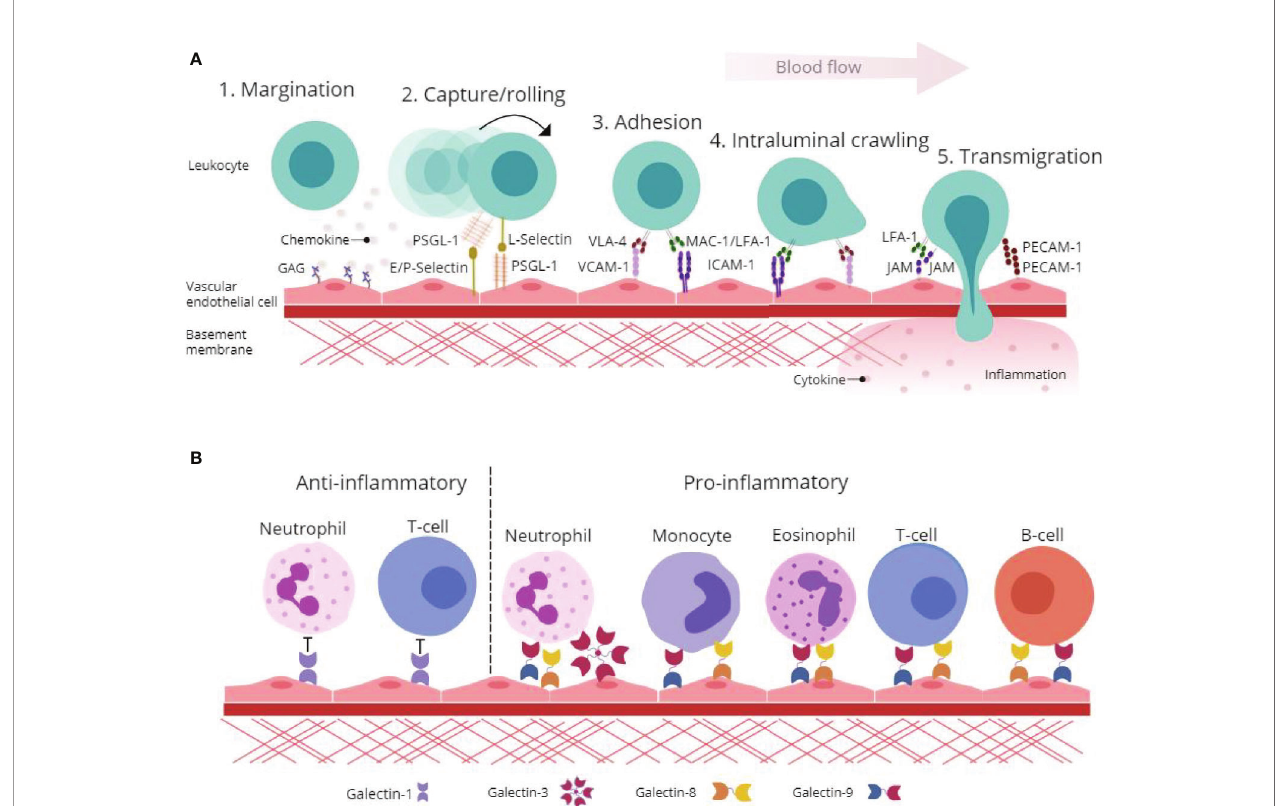
FIGURE 1 | Glycan-binding proteins regulate endothelial-leukocyte interactions in in fl ammation. (A) Protein-protein and protein-glycan interactions are crucial regulators of leukocyte-endothelial interactions involved in the leukocyte adhesion cascade. Firstly, glycosaminoglycan (GAG)-presented chemokines promote leukocyte margination to the vessel wall. Capture and rolling of leukocytes along the endothelium is facilitated by interactions between selectins and their ligands such as P-selectin glycoprotein ligand (PSGL)-1. This interaction leads to cell activation and conformational changes in leukocyte integrins including Very Late Antigen (VLA)-4, Macrophage (Mac)-1 antigen and lymphocyte function-associated antigen (LFA)-1 that then interact with adhesion molecules such as Vascular Cell Adhesion Molecule (VCAM)-1 and Intracellular Cell Adhesion Molecule (ICAM)-1 to facilitate adhesion and intraluminal crawling. Finally, transmigration through the endothelial cell (EC) layer is mediated by homophilic interactions between platelet EC adhesion molecule (PECAM)-1 and junctional adhesion molecule (JAM). (B) b -galactoside binding galectins facilitate and inhibit leukocyte traf fi cking to the endothelium to promote pro- and anti-in fl ammatory responses. Galectin-1 inhibits leukocyte- endothelial interactions to promote an anti-in fl ammatory phenotype, whilst galectin-3, -8 and -9 facilitate pro-in fl ammatory leukocyte traf fi